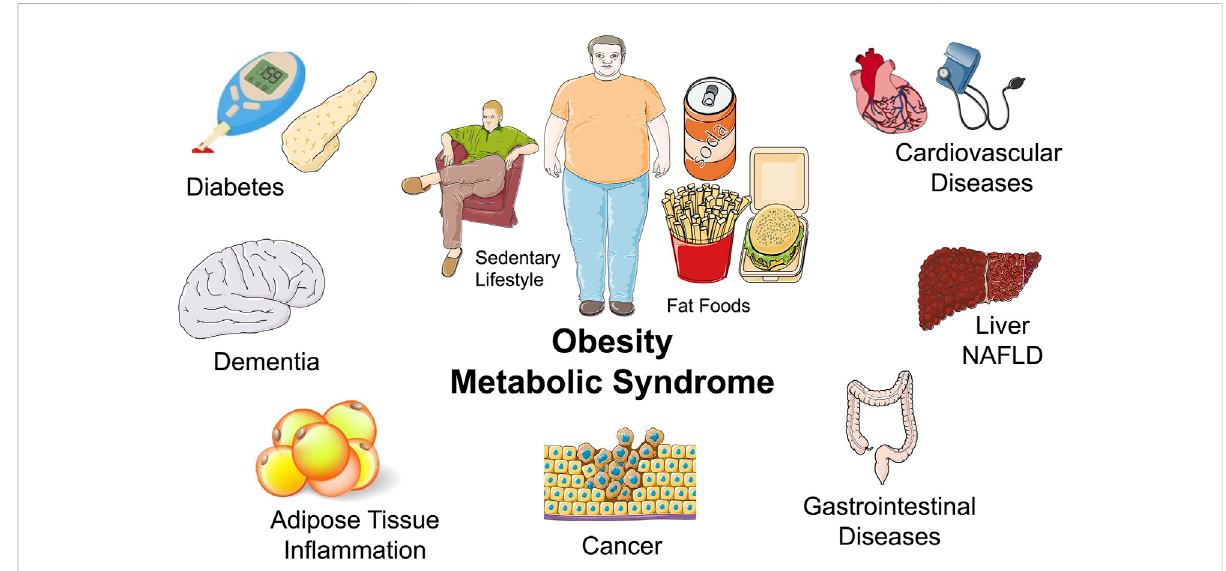
FIGURE 2 Obesity and metabolic syndrome and the epidemic of metabolic diseases: Middle: A sedentary lifestyle and a diet consisting of fat foods are major components to the obesity and metabolic disease epidemic. Surrounding: Diseases associated with obesity and metabolic diseases include diabetes, dementia, in fl ammatory diseases, cardiovascular diseases, liver disease such as non-alcoholic fatty liver disease (NAFLD), gastrointestinal diseases, and